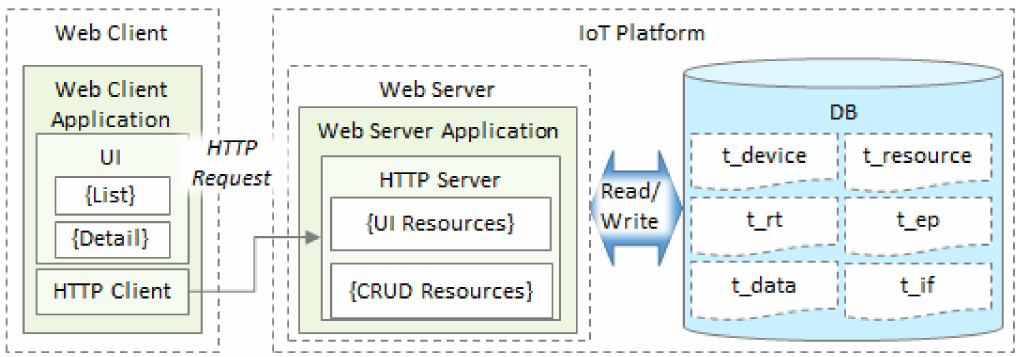
Figure 6. IoT resource discovery